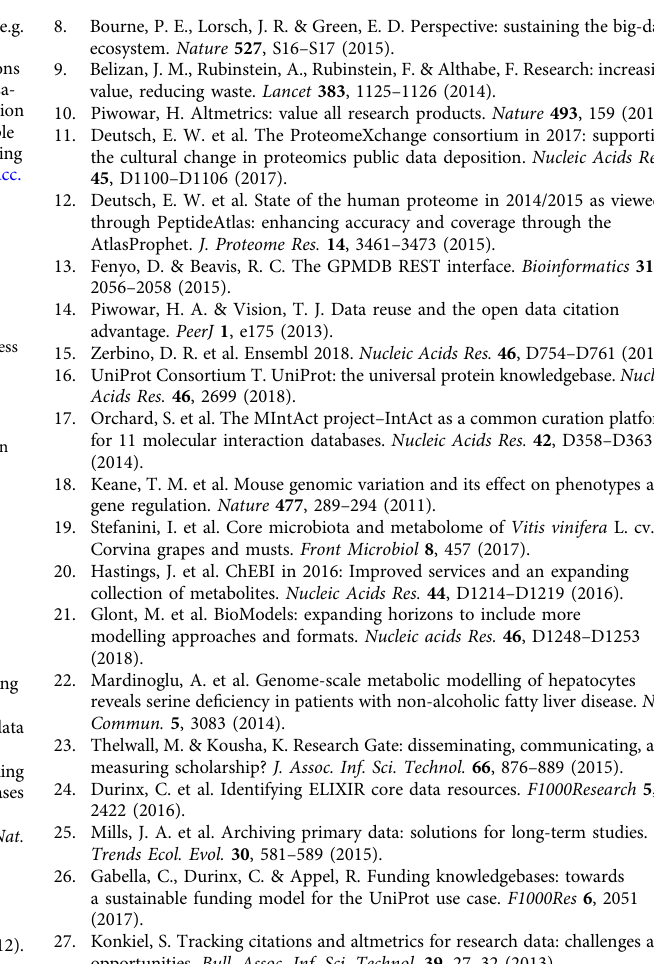
Fig. 6 The OmicsDI badge (Rosette fl ower) represents all the OmicsDI metrics. In the centre of the badge the OmicsDI score estimates the global impact using all